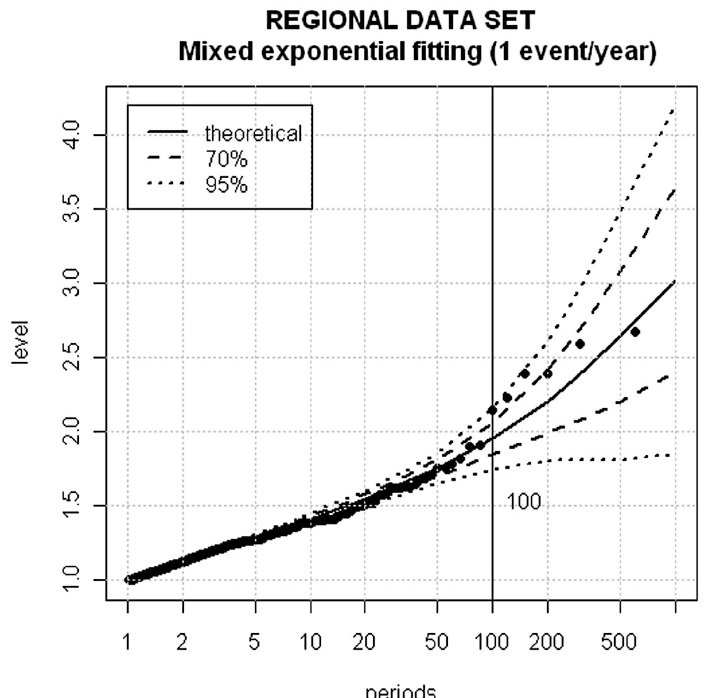
Fig. 9. Fitting of the regional data set with the mixed exponential distribution. The 70% and 95% lines correspond to confidence intervals, the surge levels do not have units (normalized surges), and the return periods are in years. The parameters of the distribution are rate1 ∼ 1.7784 (rate for the first exponential density), rate2 ∼ 5.9283 (rate for the second exponential density), and prob1 ∼ 0.0361 (probability weight for the first exponential